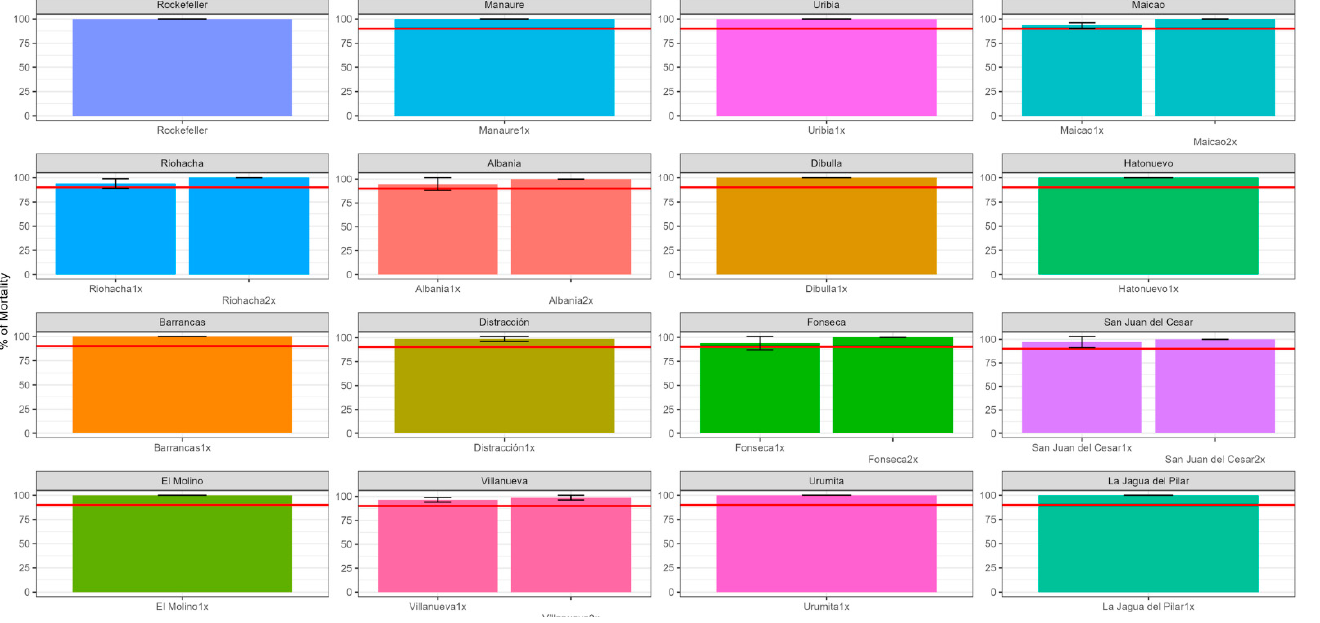
Figure 4. Mortality (with standard deviation) of Ae. aegypti following exposure to 1× DD and 2× DD of lambda-cyhalothrin in bottle bioassays. The red lines indicate the resistance threshold (90% mor- tality).